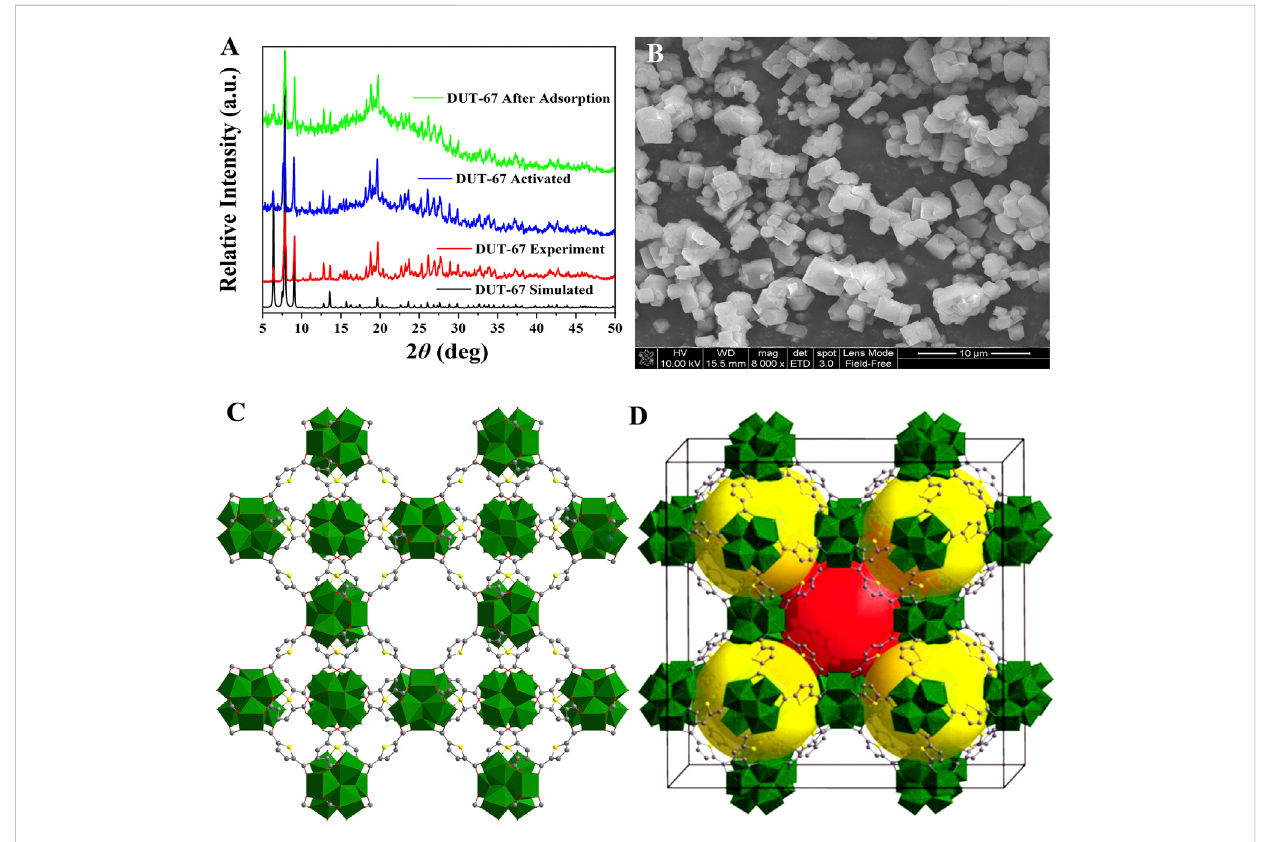
FIGURE 1 XRD (A) , SEM (B) , and the three-dimensional structure (C, D) of DUT-67